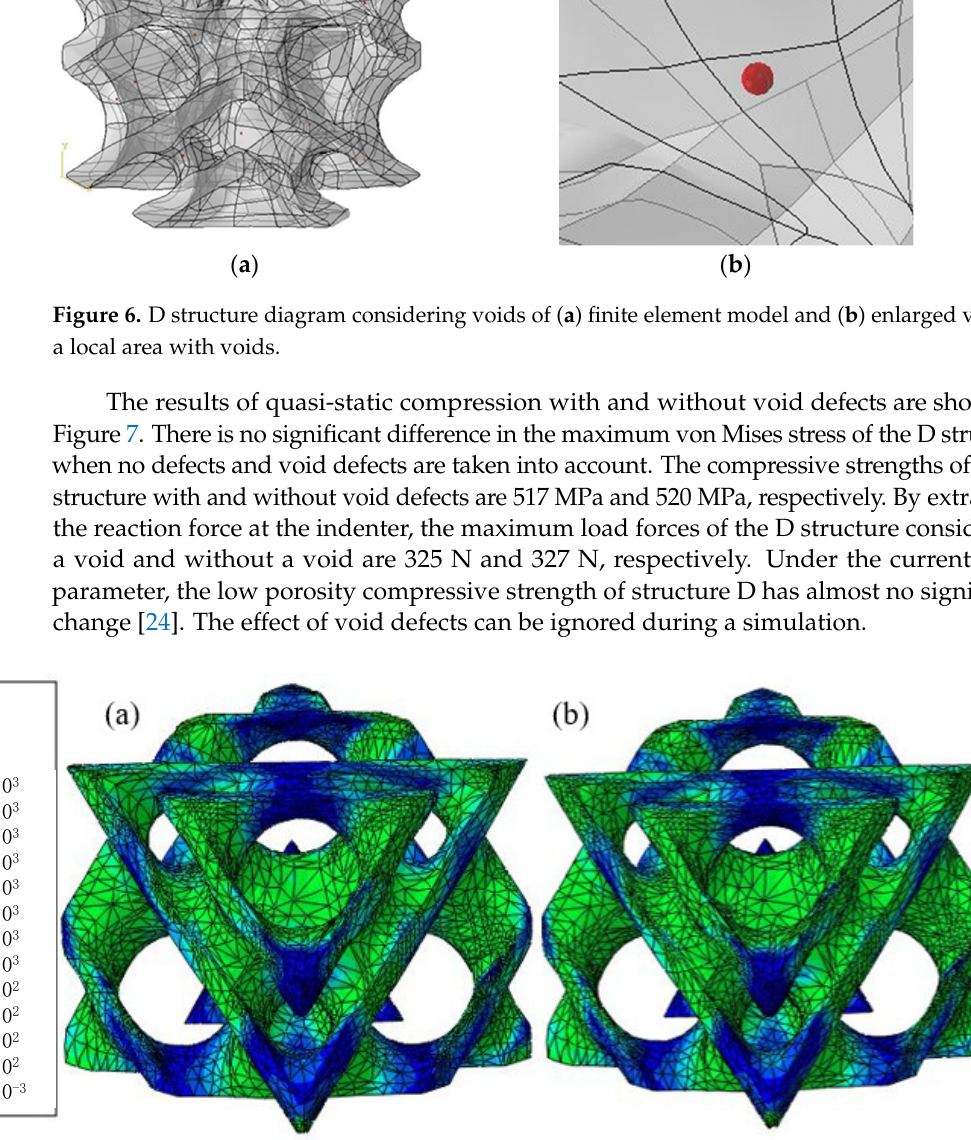
Figure 5. Assembly diagram of the D structure and rigid surface.